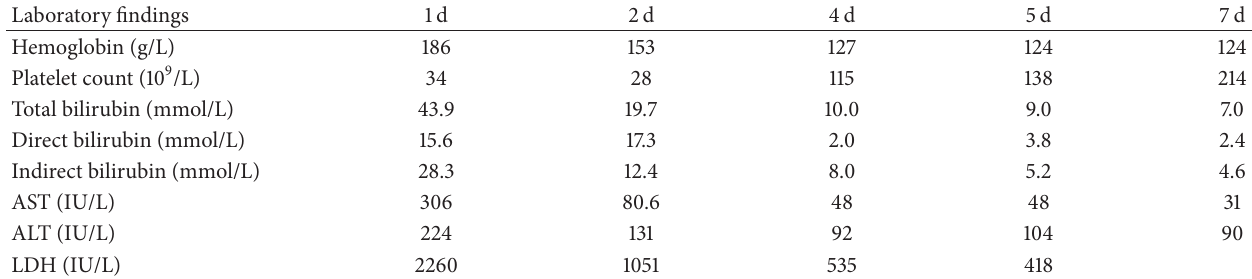
Table 2: Laboratory findings postpartum in case 2. Time